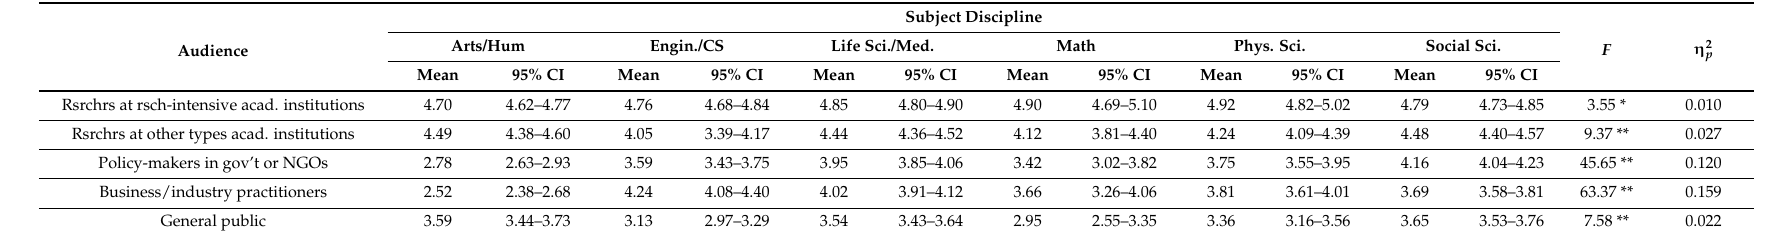
Table 14. Importance of accessibility for different audiences by subject